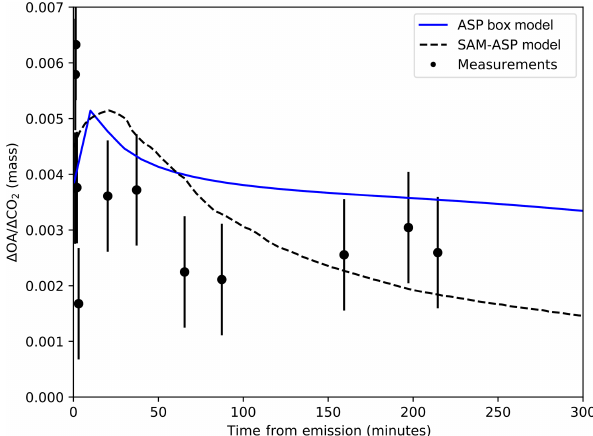
Figure 5. Cross-plume-averaged OA NEMR ( (cid:49) OA /(cid:49) CO 2 ) for the Williams fire from SAM-ASP simulations (dashed line), the ASP box model results as described in Alvarado et al. (2015) (solid lines), and OA measurements (back dots) described in Akagi et al. (2012).